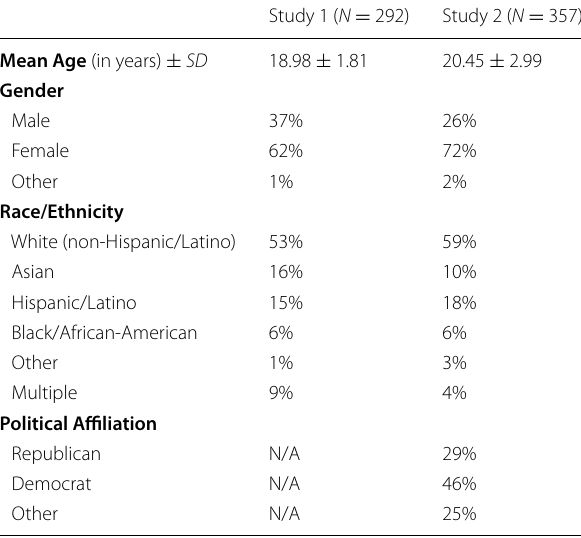
Note. SD standard =